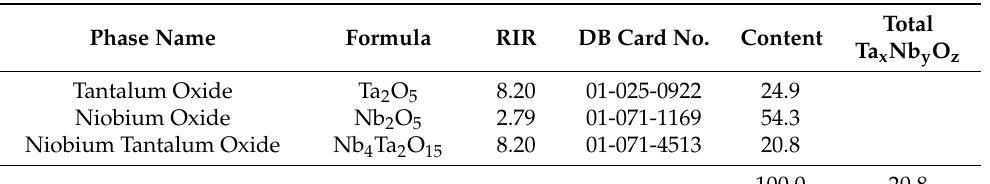
Table 6. Quantitative XRD (phase) analysis results (WPF, combined with RIR) of a 70 mol% Nb 2 O 5